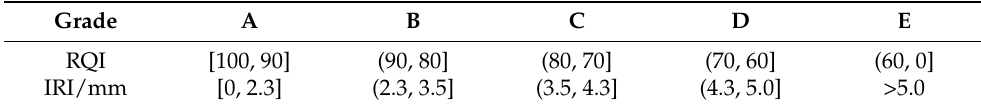
Table 3. Grades of pavement flatness.